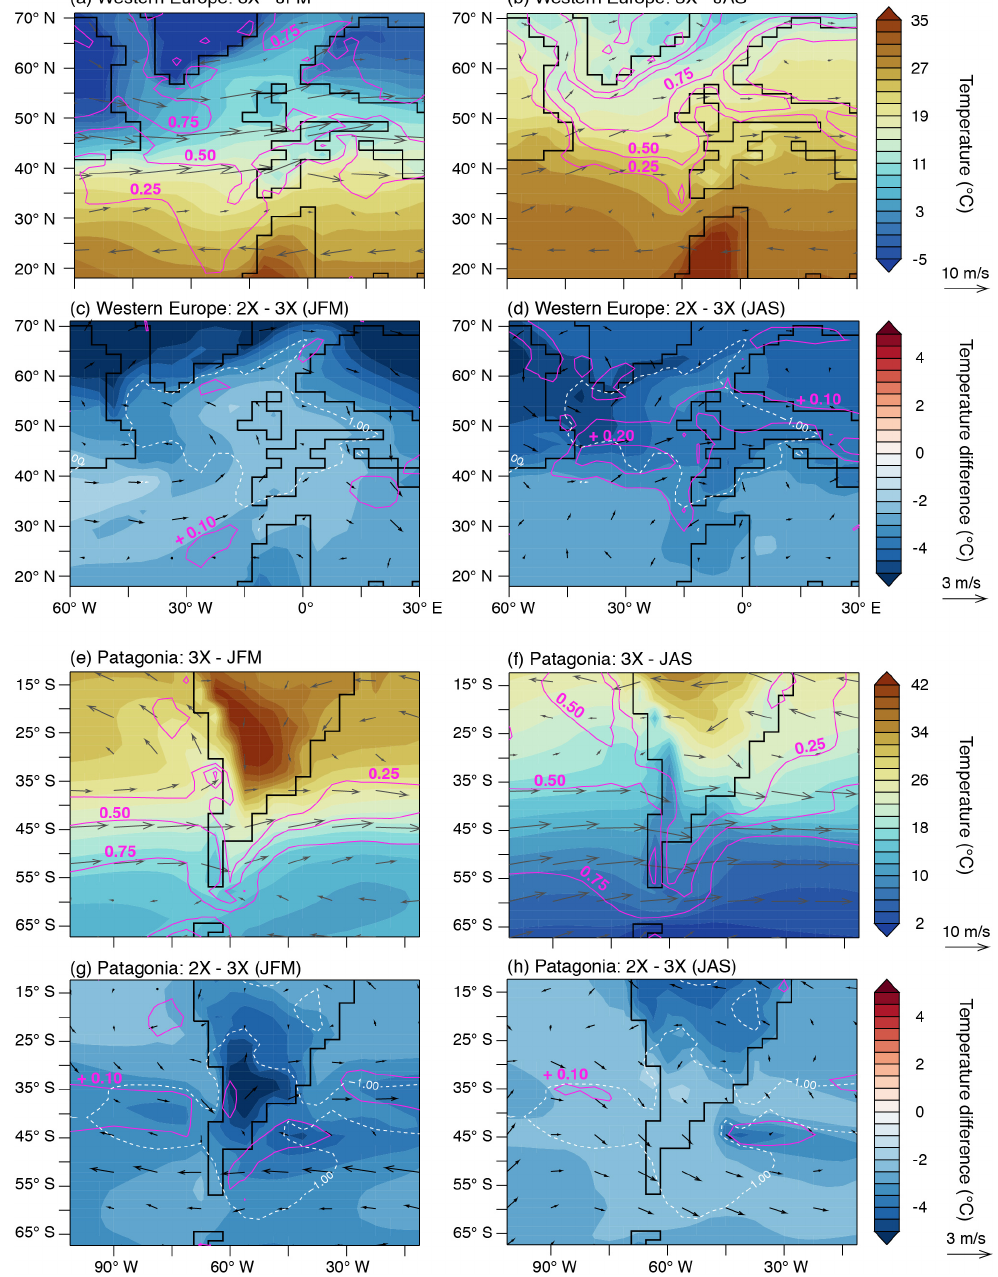
Figure 7. Two-meter atmospheric temperature across western Europe and Patagonia. Shadings correspond to temperatures ( a , b , e , f ) and temperature differences ( c , d , g , h ). Similarly, magenta lines contour low-level fraction ( a , b , e , f ) and low-level cloud fraction changes ( c , d , g , h ; always expressed in %) and arrows, 850hPa winds ( a , b , e , f ) and 850hPa wind changes ( c , d , g , h ; always in ms − 1 ). White dashed lines contour areas with decreased seasonality ( (cid:49) MATR ≤ − 1 ◦ C) in 2 X − 3 X simulations (blue zones in Fig.